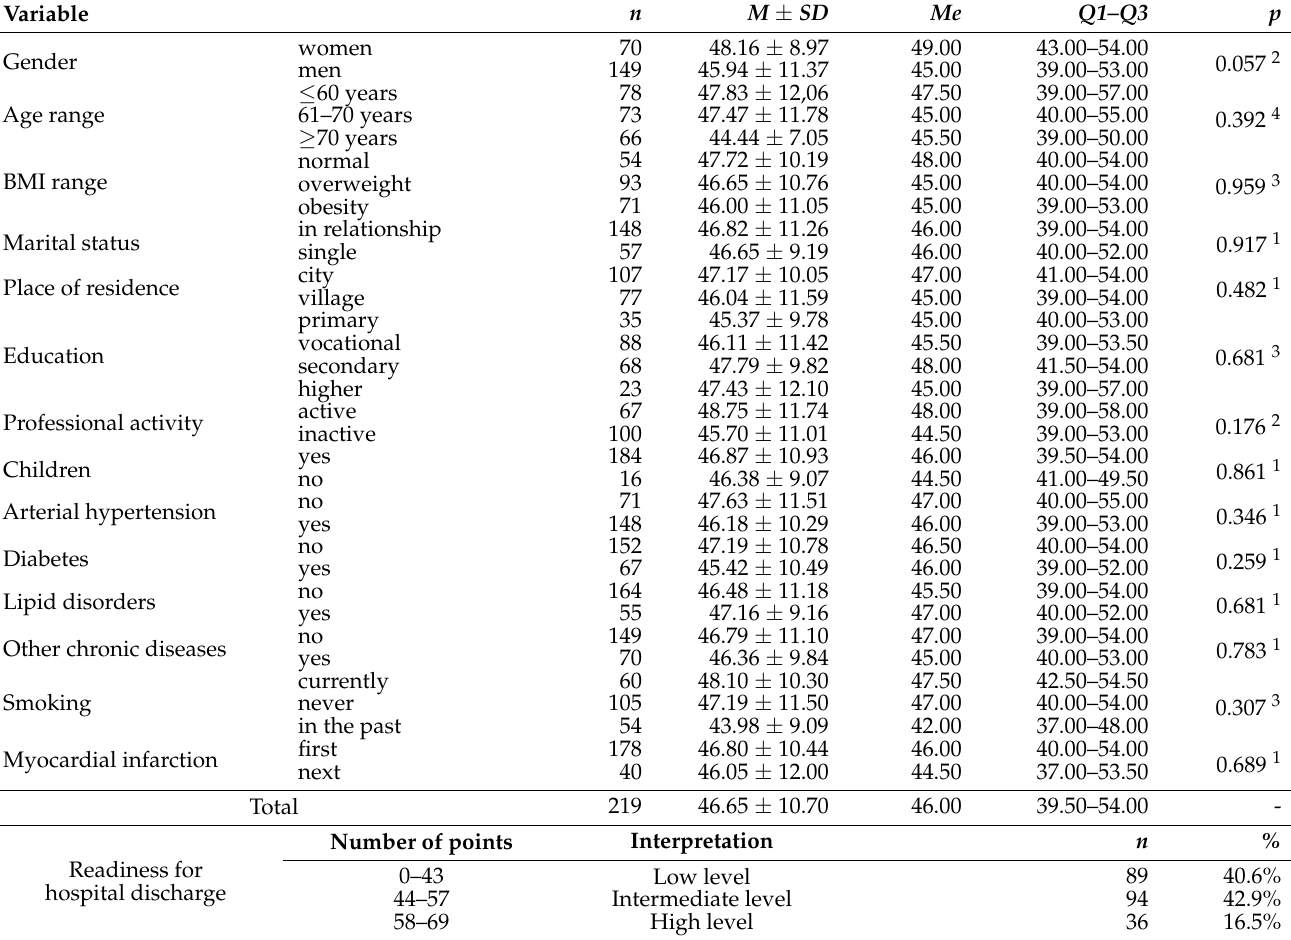
Table 1. The socio-demographic and clinical variables on general readiness for hospital discharge in MI